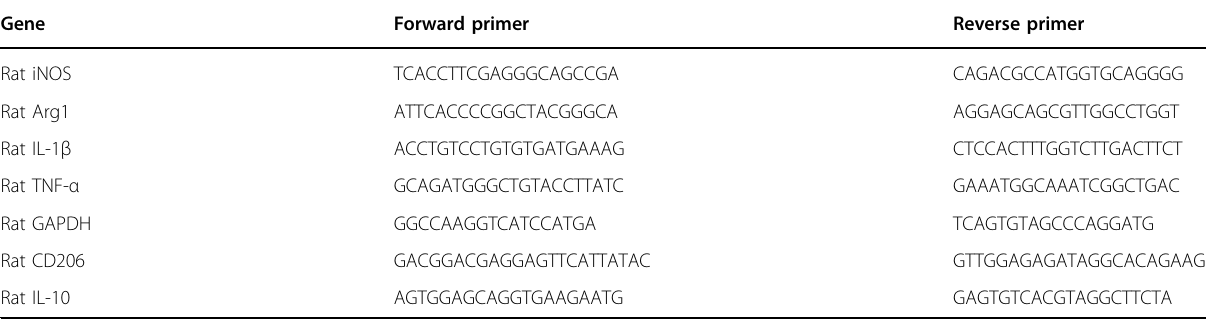
Table 1 Primer sequences for the real-time PCR analysis